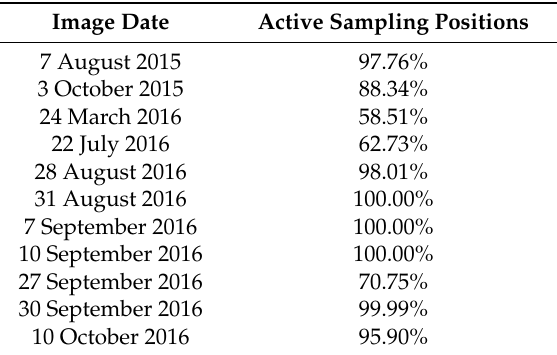
Table 3. Proportion of the sample positions on the images.